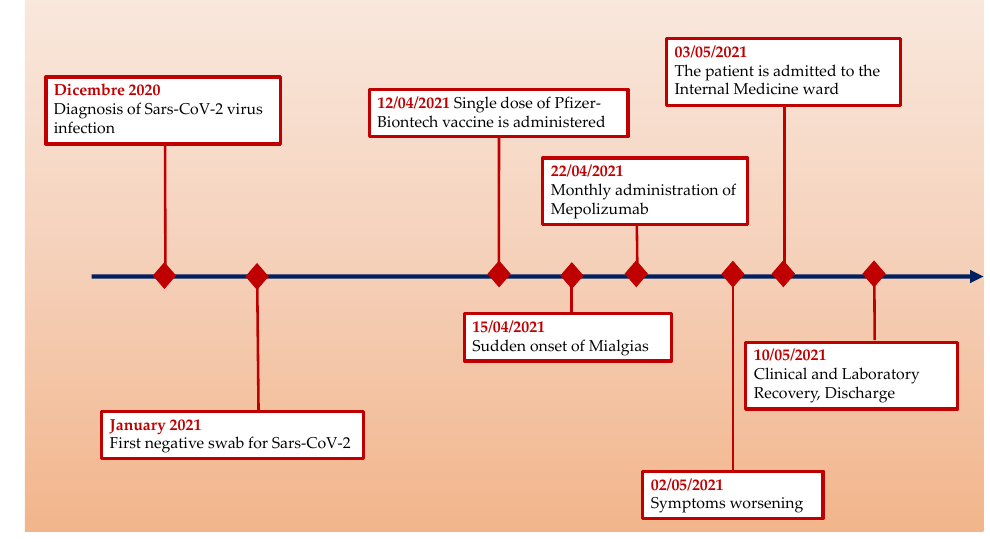
Figure 1. Clinical